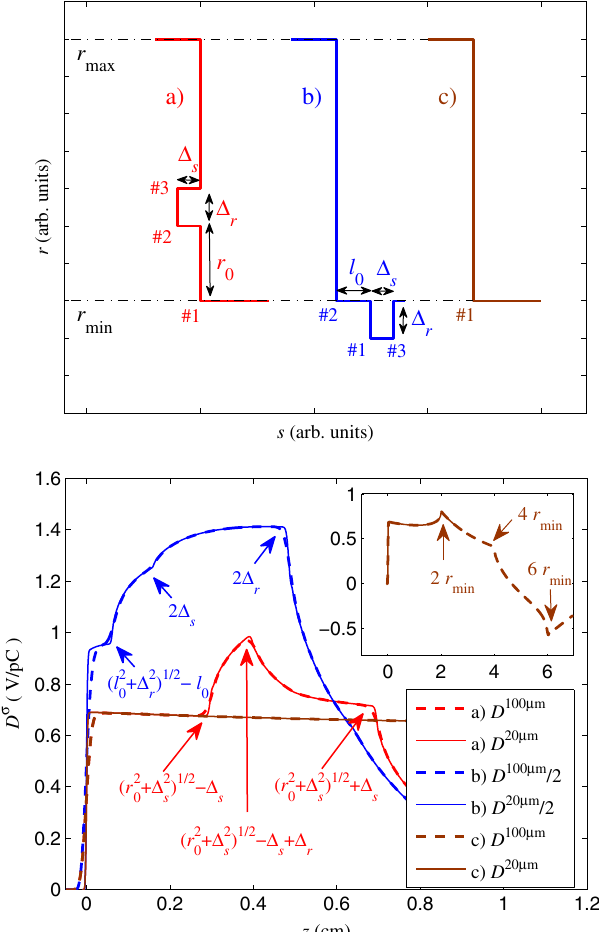
FIG. 2. (top) Step-in geometry with a lateral (a), or a radial (b) protrusion and without protrusions (c); (bottom) corresponding functions D (cid:1) ð z Þ , calculated for r ¼ 4 : 5 mm , (cid:1) r 0 = 3 ¼ 0 : 8 mm (cid:1) r